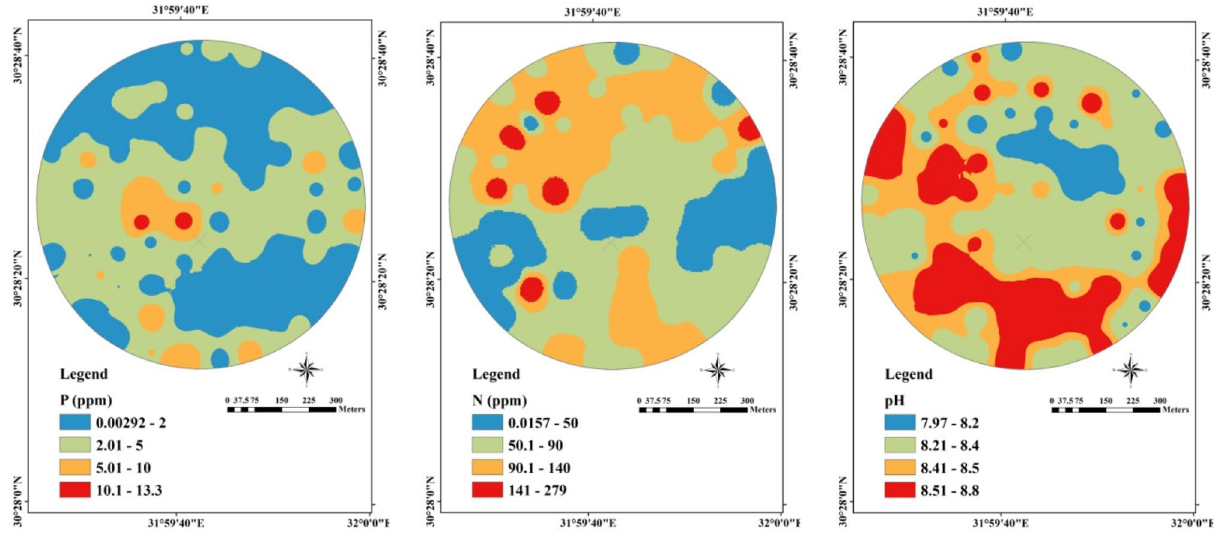
Figure 27. The GIS-generated